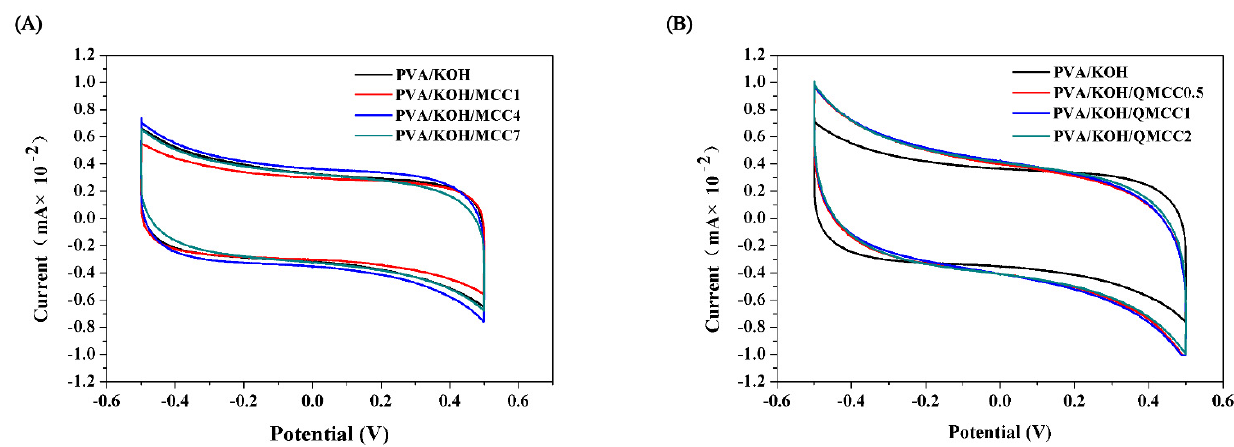
Figure 7. ( A ) Cyclic voltammetry curves of PVA/KOH/MCC alkaline electrolyte membranes. ( B ) Cyclic voltammetry curves of PVA/KOH/QMCC alkaline electrolyte membranes.